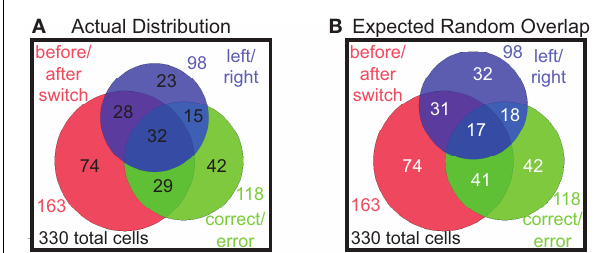
FIGURE 9 | Distributions of multiple responses. (A) The actual distribution of cells responding to the three key binary factors and the overlap of cells that represent multiple factors. (B) Expected distribution overlap if the factors combined independently (i.e., 163/330 = 49% before/after switch responding, 118/330 = 36% correct/error responding, 98/330 = 30% left/right